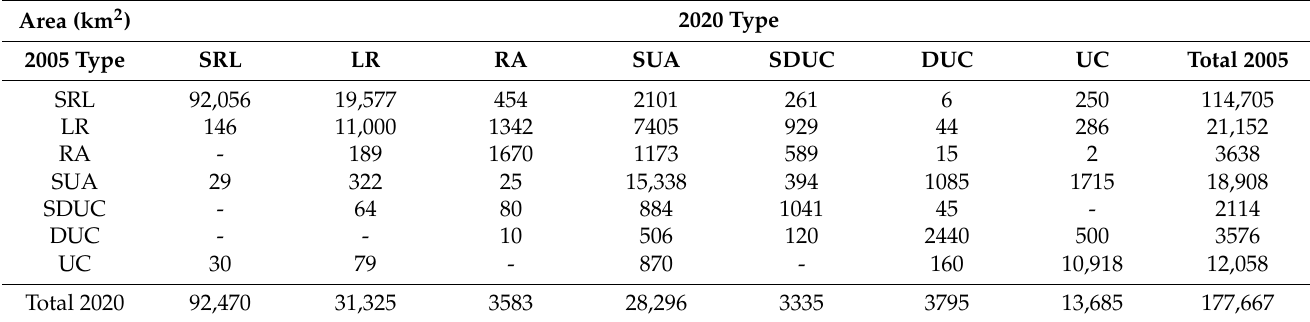
Table A2. Guangdong Province Built-up Spatial Density Type Transition Matrix.